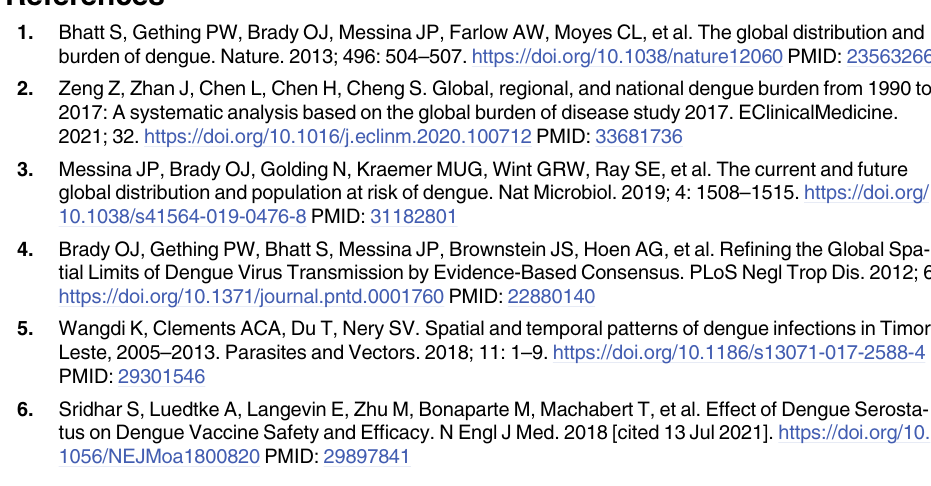
S1 Fig. Histogram showing antibody responses in serum samples from all individuals with commercial cut-off values